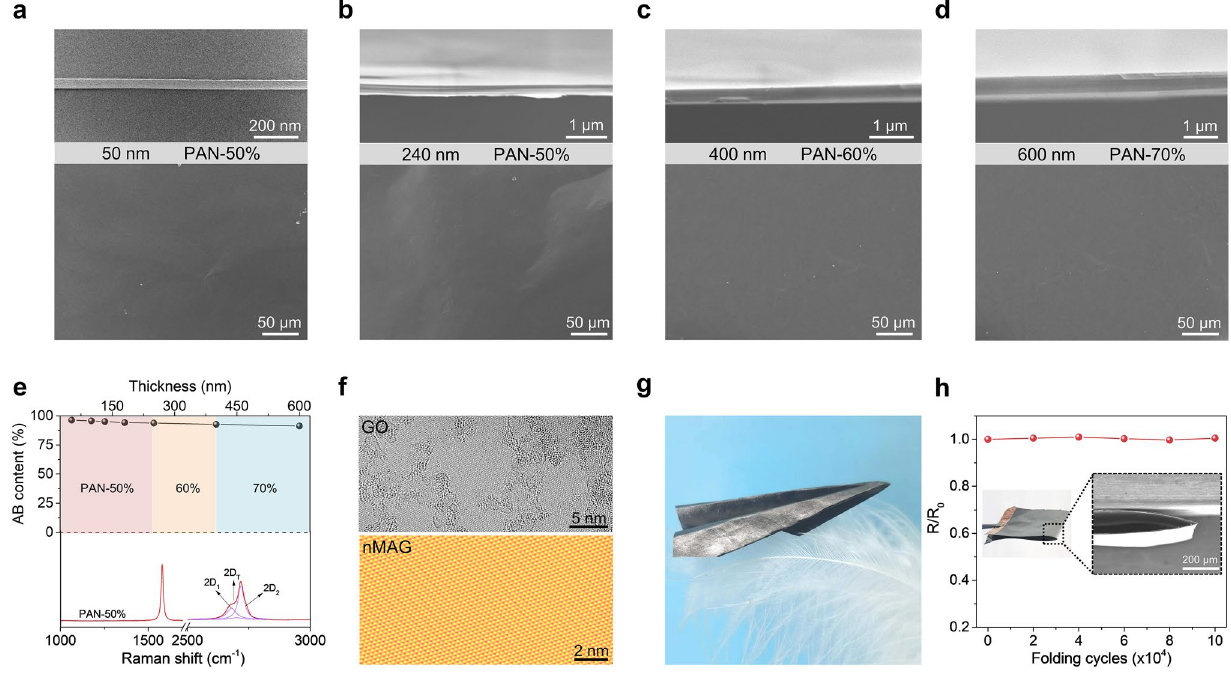
Fig. 3 Structure and flexibility of nMAGs. a HR-TEM (cross-section, Up) and SEM (surface, Down) images of 50 nm-thick nMAG. b – d Cross- sectional and surface SEM images of nMAGs with different thicknesses. e AB content of nMAGs with different thicknesses (Up) and Raman spectrum of a 50-nm-thick nMAG (Down). f HR-TEM image of GO (Up) and STM topography image of nMAG (Down). g Paper plane folded with 600-nm-thick nMAG. h Resistance variation of 600-nm-thick nMAG after repeated